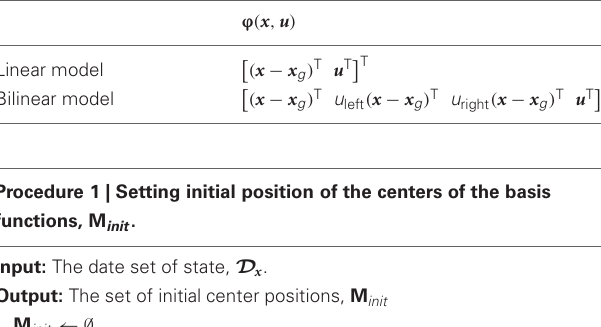
Table 2 | Basis functions used in the robot experiment.